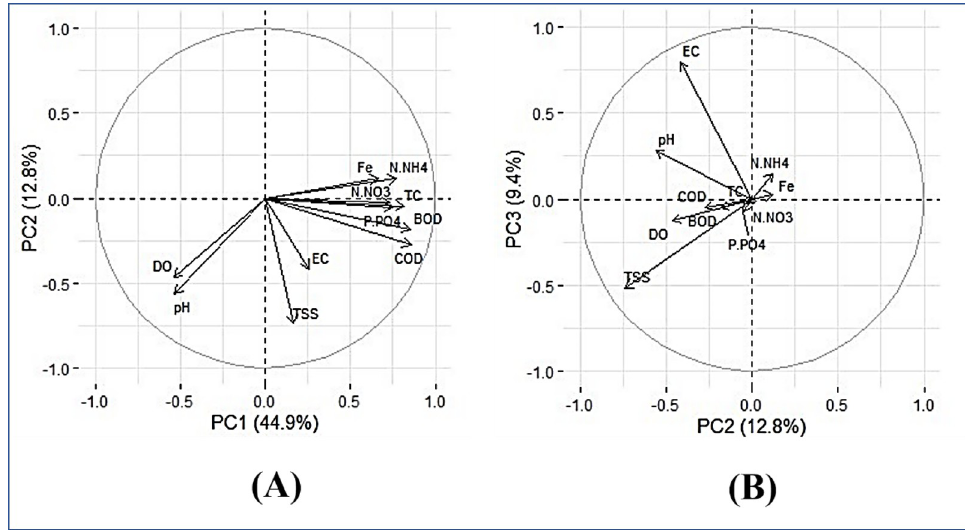
Fig 2. Loading plots: (A) PC1 × PC2 and (B) PC2 × PC3. https://doi.org/10.1371/journal.pone.0274673.g003 of variance explained by each variable in the factorial solution, are calculated. Table 4 presents the squared loadings and communality values for the variables on three principal components (PC1 –PC3). The largest communality value in the column is for the parameter EC (0.875), providing the greatest relative weight (w ) and the smallest communality value for Fe (0.452), i giving the smallest relative weight. Then, the procedure to define the relative weight (w ) of i each parameter is easily conducted by dividing its communality value by the sum of the com- munality values in the column (7.374). Using the communality values and the procedure defined in this study, the relative weight (w ) for each parameter is calculated and exhibited in i Table 4. The sum of the eleven weights adds to one (1.00). Thus, the PCA helped to define the weight of importance for each parameter, independent of subjective assessments. The next step is to transform the concentration monitored for each param- eter, into dimensionless grade (sub-index q ), to calculate the WQI value for each water sample. i Table 4. Square loadings, communality values and relative weights for the parameters.